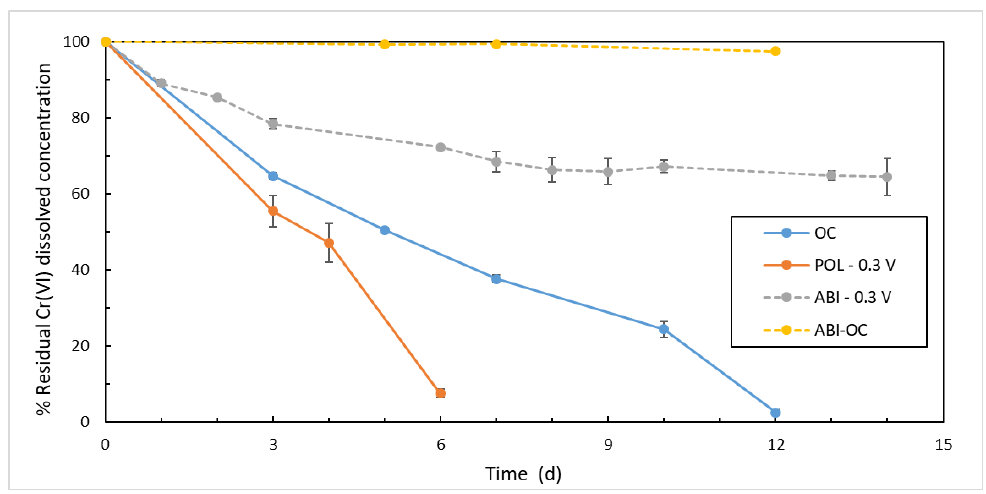
Figure 4. Reduction of Cr(VI) concentrations over time in ABI-OC (yellow dashed line), OC (blue solid line), POL −0.3 V (orange solid line), ABI −0.3 V (pink dashed